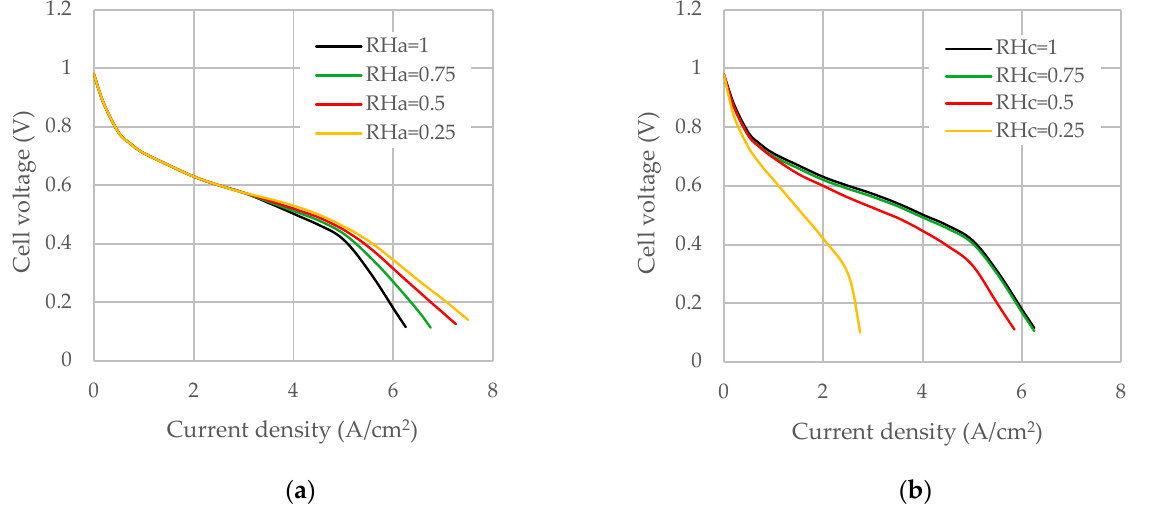
Figure 12. The effect of different inlet RHs in ( a ) anode and ( b ) cathode on cell performance. Figure 12b illustrates the impact of changing the RH c while keeping RH a at 1. Since the water consumed cannot be replenished quickly enough by the water present in the inflow stream, cell performance drops at low RH c values and high current densities. The higher the humidity level in the cathode, the better the cell performs with a fully humidified cathode, leading to the best results. The cell reaches the limiting current density of 6 Acm − 2 at RH c of 0.5, which is almost two times the value reached when the cell operates at an RH c of 0.25. This can be explained by changes in water transport at varying current densities. More water is consumed in the cathode as the current density rises. As a result,